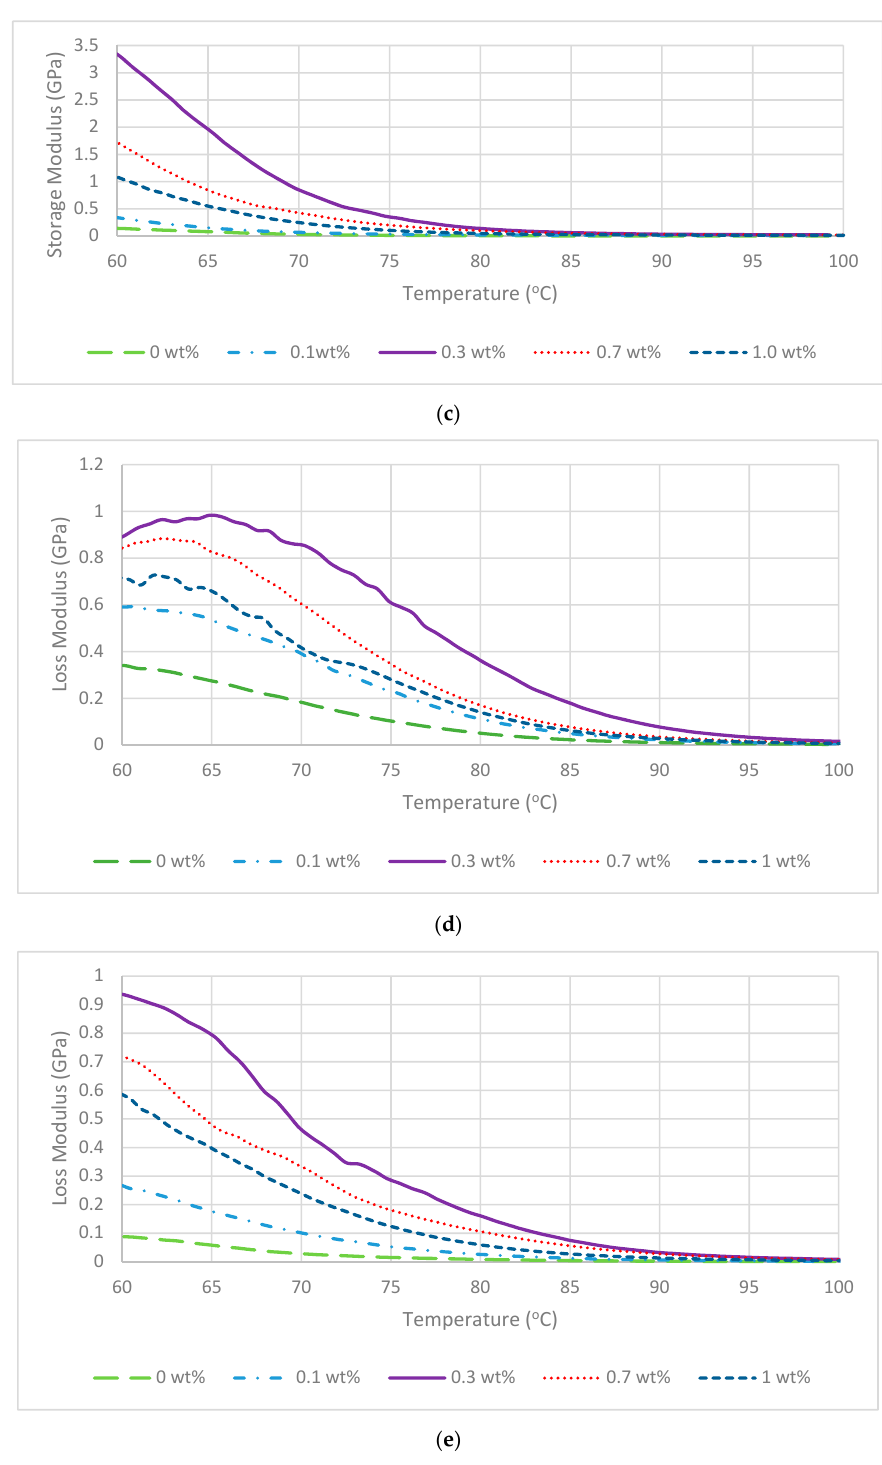
Figure 4 . Dynamic mechanical properties: ( a ) glass transition temperature; ( b ) storage modulus of nanocomposites in air; ( c ) storage modulus of nanocomposites after seawater exposure; ( d ) loss modulus of the nanocomposites in air; and ( e ) loss modulus of nanocomposites after seawater exposure. The maximum seawater absorption is presented in Figure 5a. After five days of seawater exposure, monolithic polyester recorded the highest seawater absorption with 1.37%. The seawater